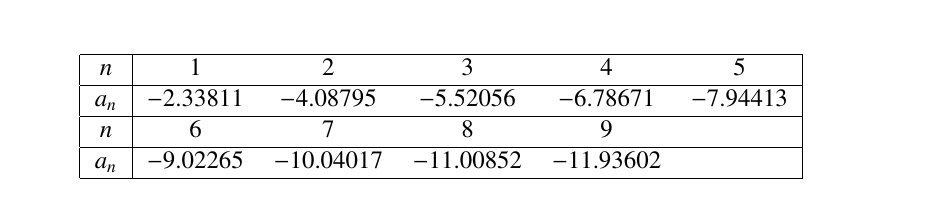
Table 1. First 9 zeros of the function Ai( z